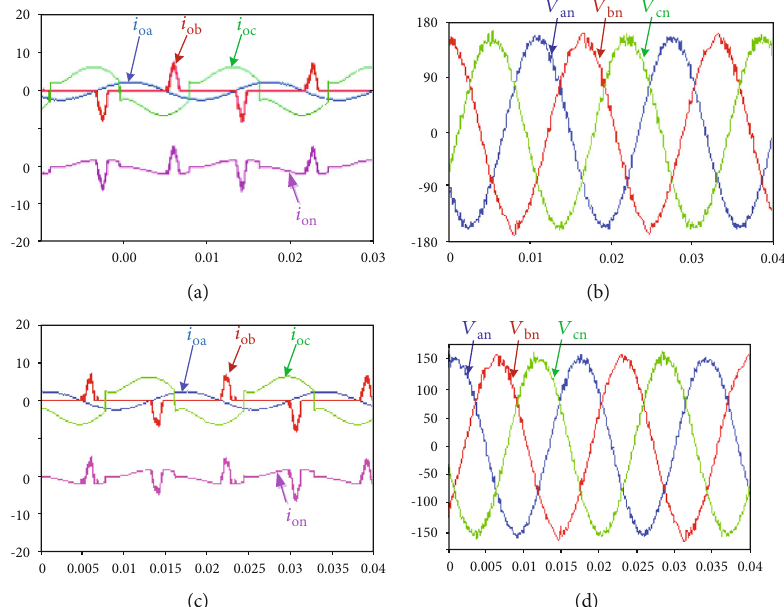
Figure 5: The simulation results under nonlinear load: DB controller: (a) load currents and (b) load voltages; hybrid controller: (c) load currents and (d) load voltages.